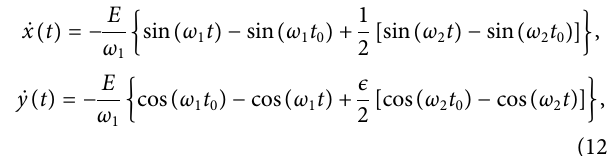
(cid:1) 5 τ (cid:1) 10 τ 1 2 (580 as FWHM), and relative CEP lp